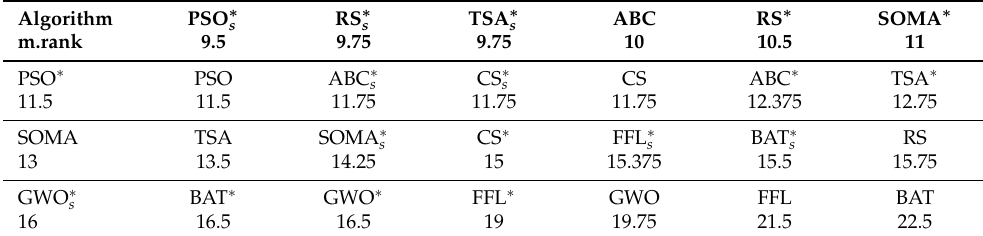
Table 15. The mean ranks of all algorithms from the Friedman test.